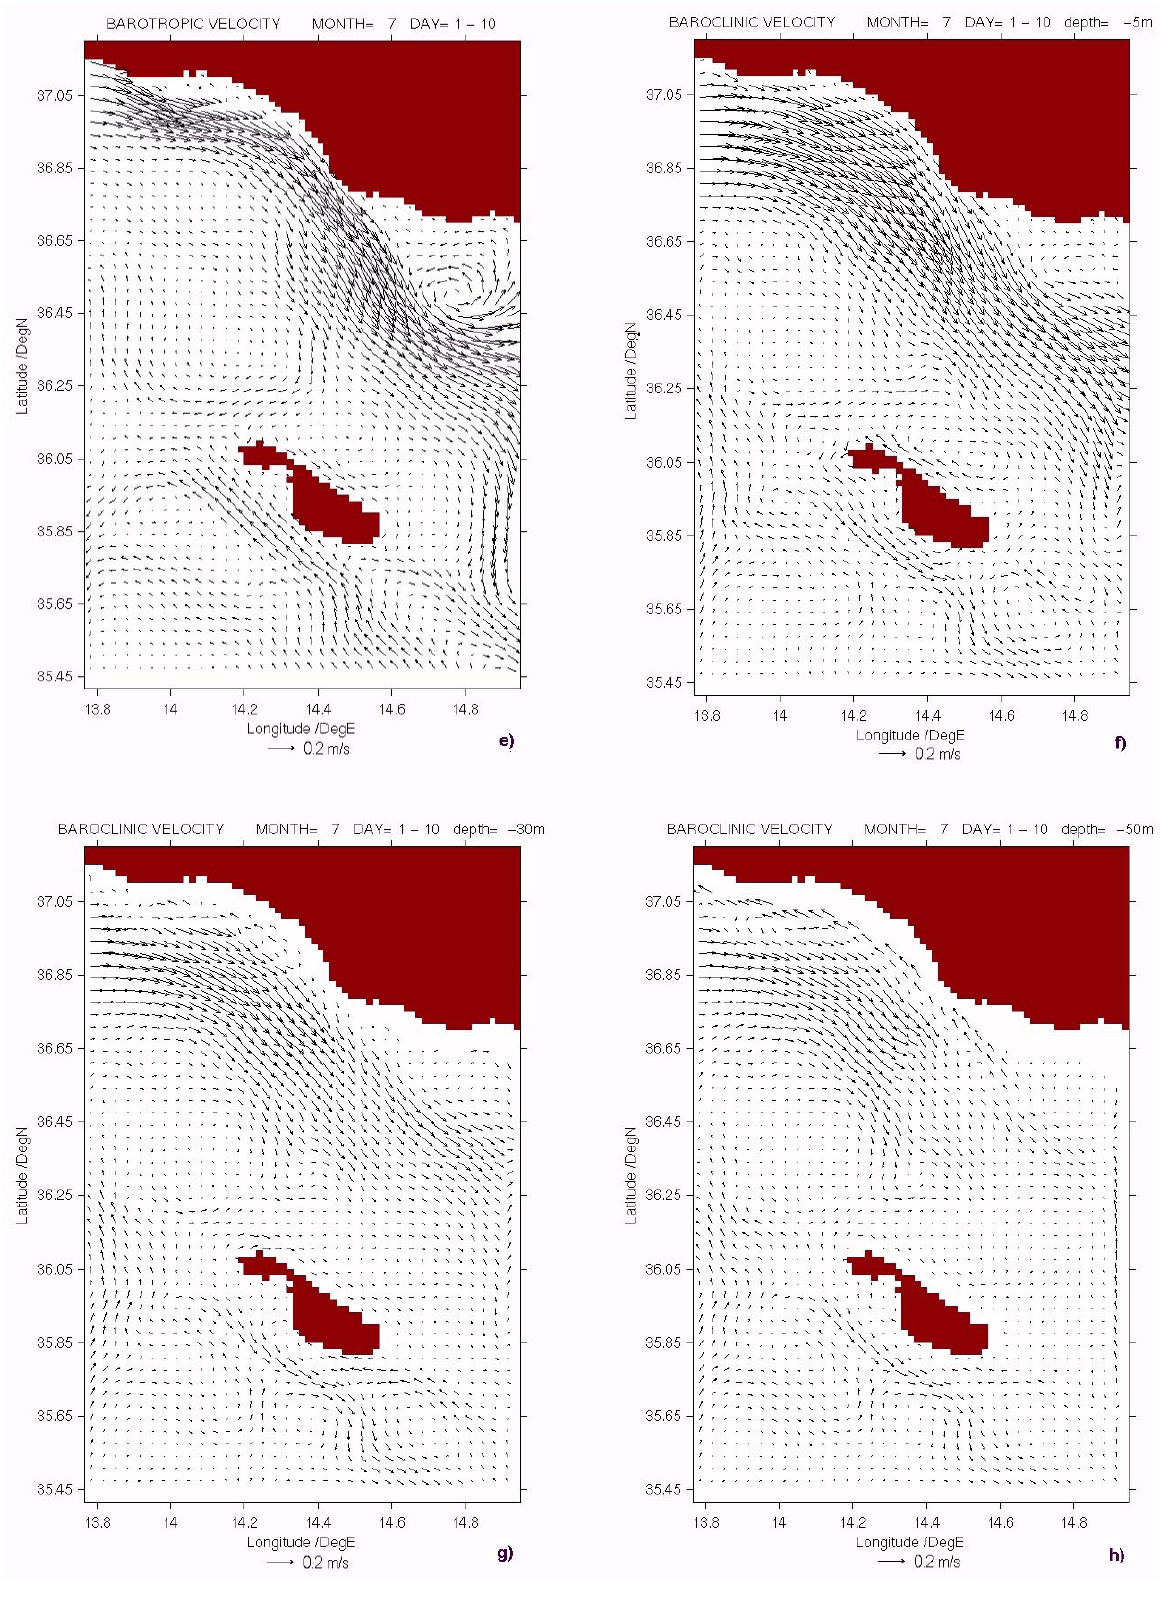
Fig. 15. Continued: Horizontal fields of (e) barotropic velocity, and baroclinic velocity at (f) 5 m, (g) 30 m and (h) 50 m depth, for the first ten days of July. Plotting is done only at every odd grid